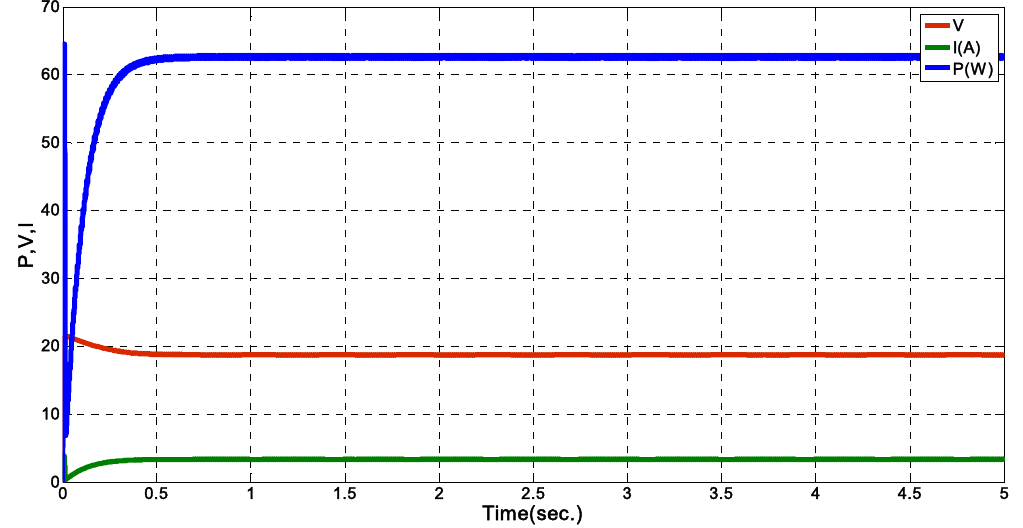
Figure 17. Time response of a SMESC system in the context of an abrupt irradiance change from 1 kW/m 2 to 600 W/m 2 at time = 2 s. ( a ) the output power, voltage and the current waveforms; ( b ) the sliding